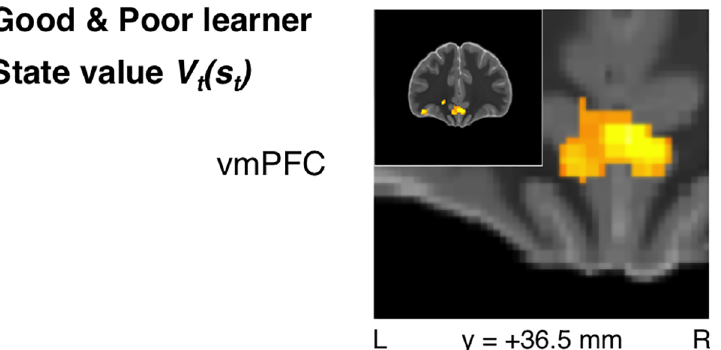
Fig 4. All performing participants: State-value signals. State value V t (s t ) signals were observedin ventromedial prefrontalcortex (vmPFC) across all performingsubjectsas hypothesized ( p < 0.005 unc., SVC p FWE <